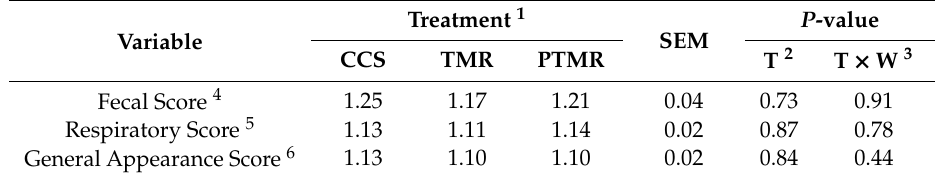
Table 8. Least square means of health parameters fecal score, respiratory score, and general appearance score of crossbred calves fed conventional calf starter and oat hay as TMR or in pelleted form.